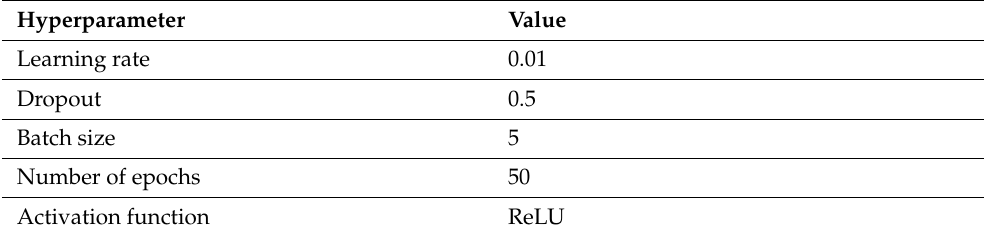
Table 1. Hyperparameter